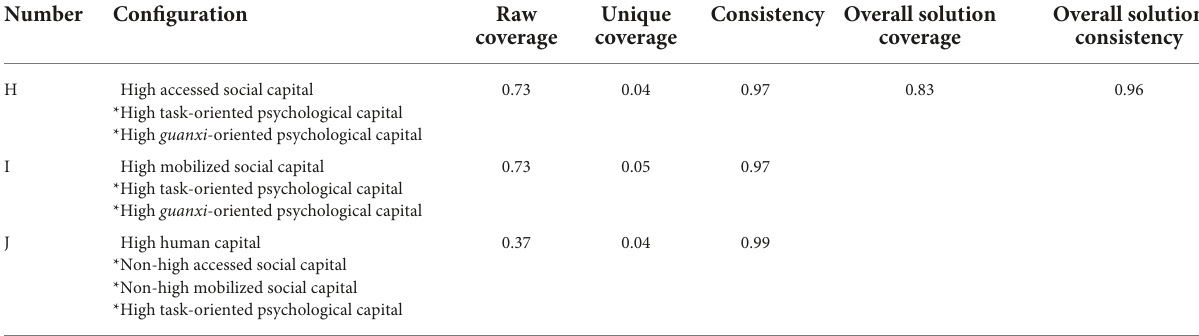
TABLE 5 Configurations for the achievement of high contextual performance * high contextual